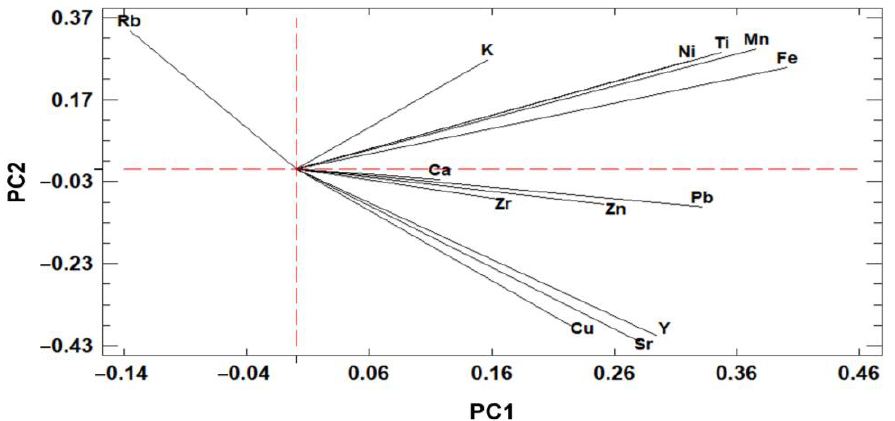
Figure 3. First two components of the principal component analysis of the indoors sample.